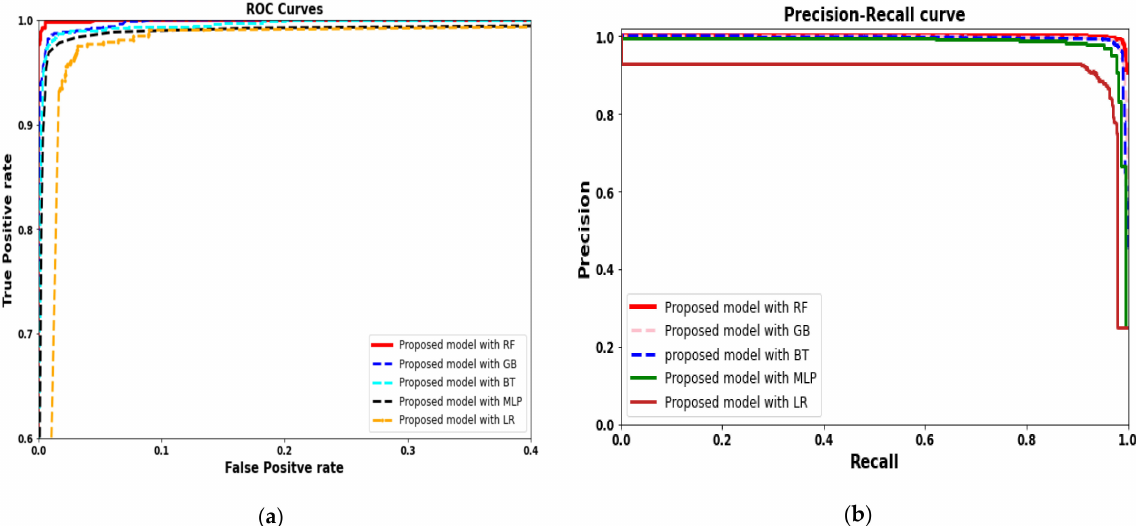
Figure 9. ( a ) ROC for proposed deep-learning model, with feature extraction using various machine-learning models. ( b ) Precision–recall curves for the proposed model, with feature extraction using various machine-learning